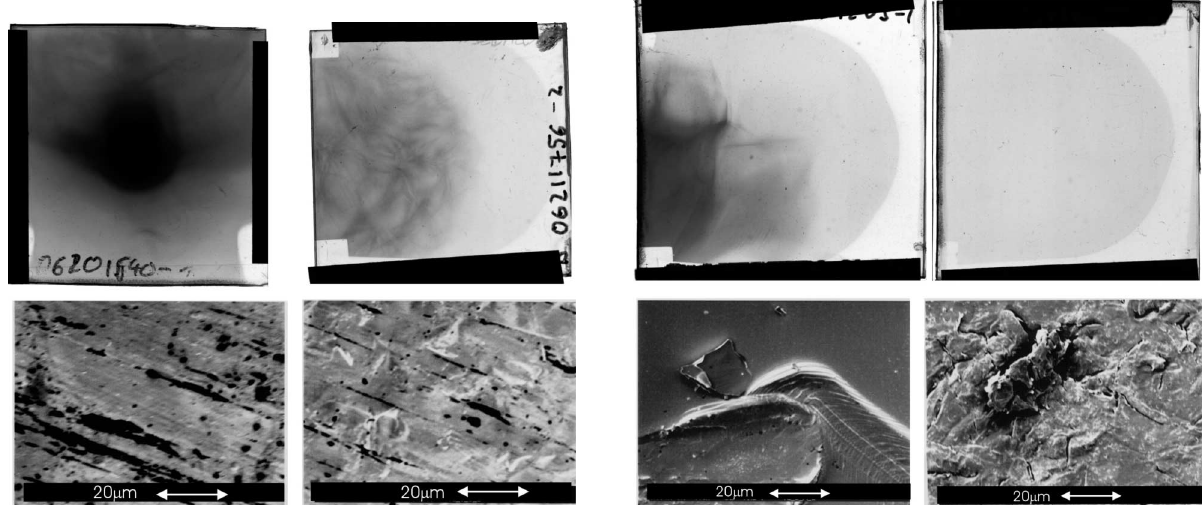
FIG. 3. Proton emission from smooth and roughened rear surfaces of gold (two left-hand columns) and plastic targets. The rough- ened surface in the case of gold leads to the onset of filamentation. No protons could be detected from the roughened plastic targets due to the destroyed surface. The scanning electron microscope (SEM) images show the corresponding structures of the surfaces [note that the structure visible for the smooth plastic target (third, lower inset) was an artifact to focus the SEM]. The overall surface of the target was similar to the upper right-hand